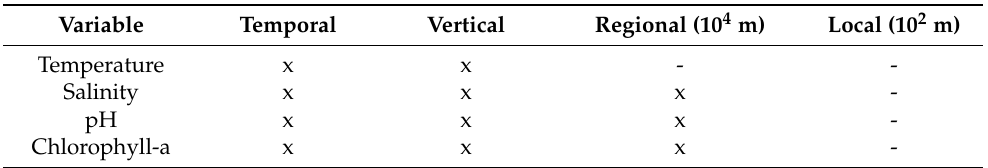
Table 7. Relevant scales (x) of water property variables, based on ordinary and multilevel regression modelling.